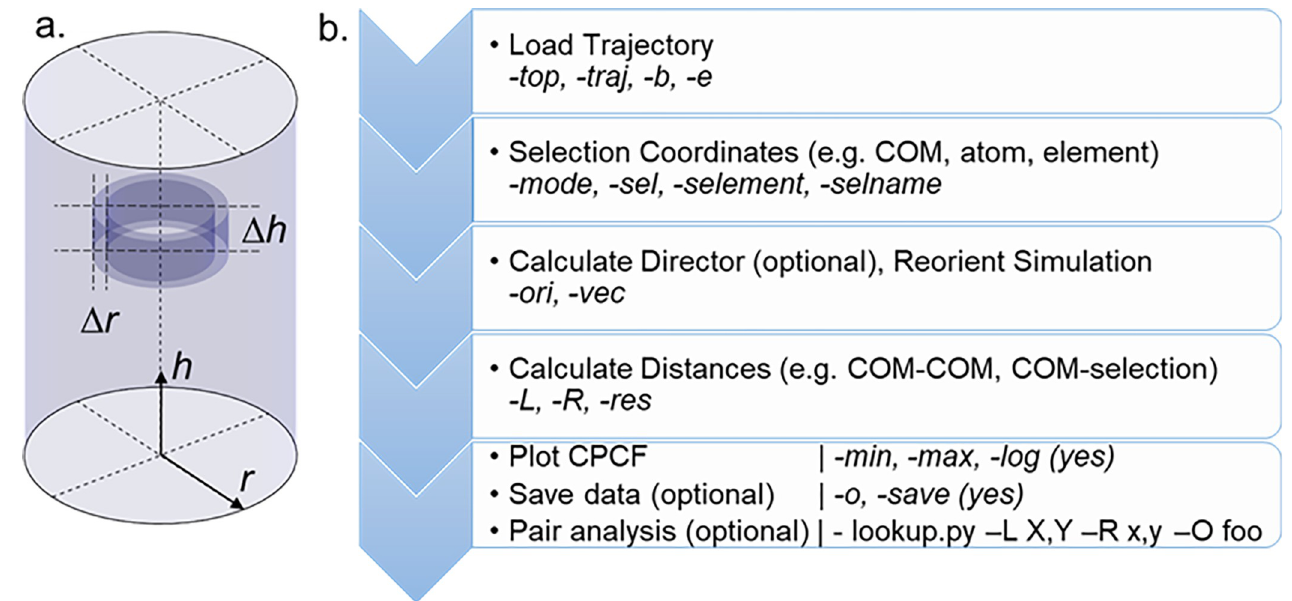
Fig 1. (a) Illustration of the cylindrical binning procedure, where Δ r and Δ h are the radial and length windows used in a given cylindrical bin; (b) Operations performed by cylindr , with user inputs shown in